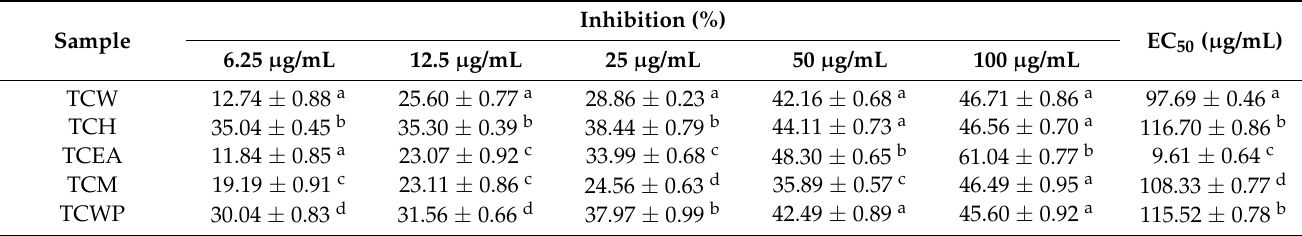
Table 4. Antioxidant activities of cocoa pod husk extracts.